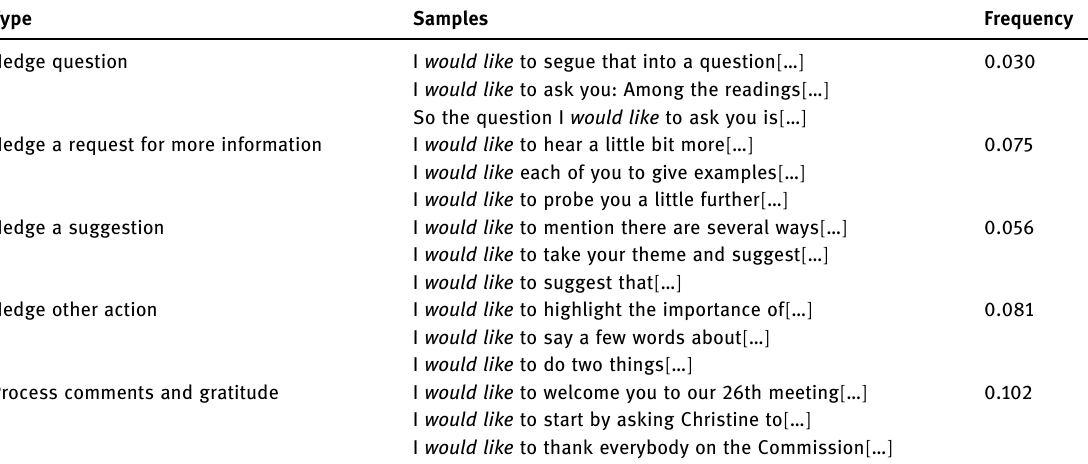
Table 10: “ I Would like ” concordances, grouped and counted by type, with frequency as per cent of total tokens ( normalised n = 1,000 )